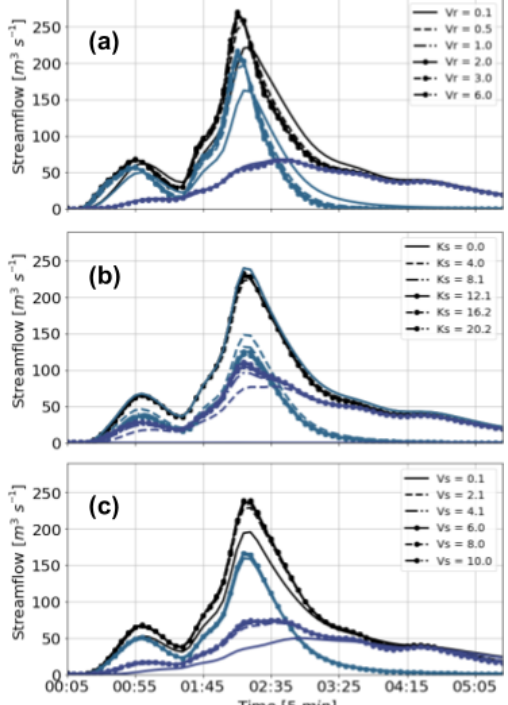
Figure 10. Hydrological simulation sensitivity analysis. Similarly to Fig. 9, all the panels show the simulated streamflow (purple) and the runoff (green) and subsurface flow (dashed purple) separation. From top to bottom, the panels show the simulation sensitivity to changes in the (a) surface speed, (b) infiltration rate, and (c) sub- surface speed